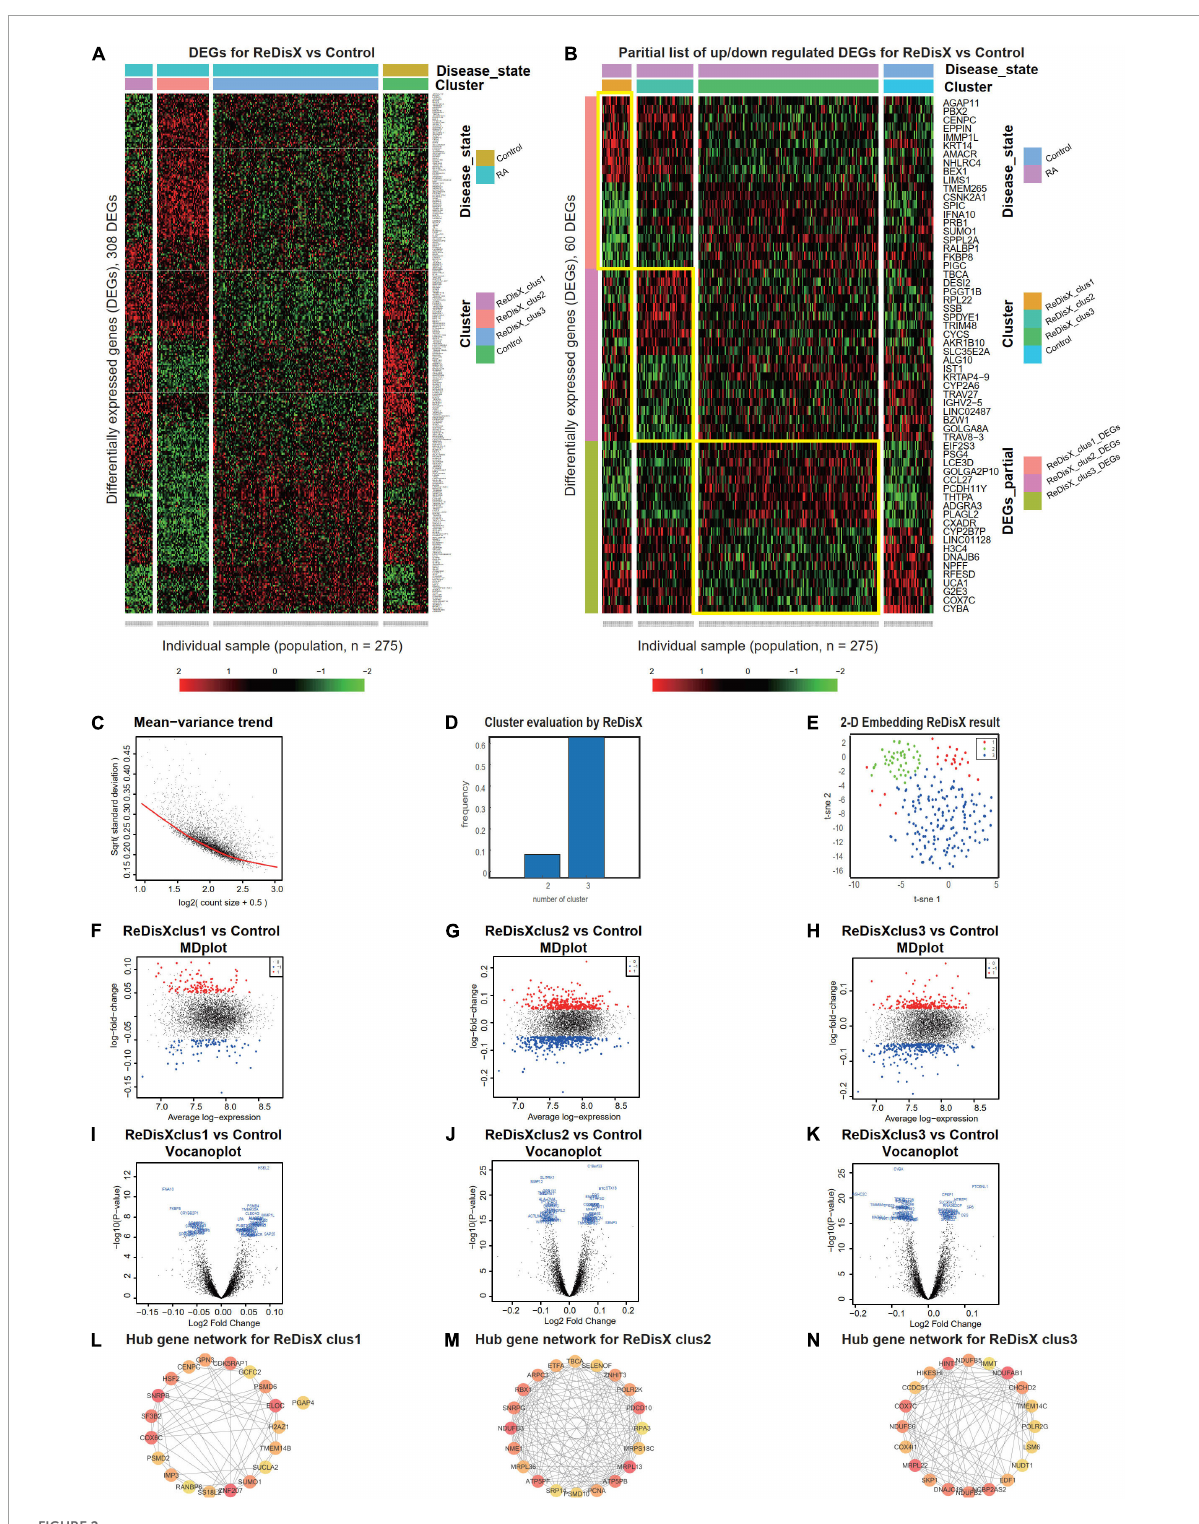
FIGURE2 ReDisX redefines the RA patients through acquiring personalized and précised molecular-genetic information. (A) Heatmap for relative expression in up/downregulating DEGs identified in GSE93272 ( p -value < 0.05, log fold change > 0.05, non-overlapping DEGs with other subpopulations). (B) Randomly selected 10 up-regulating genes and 10 downregulating genes corresponding to each ReDisX-based cluster